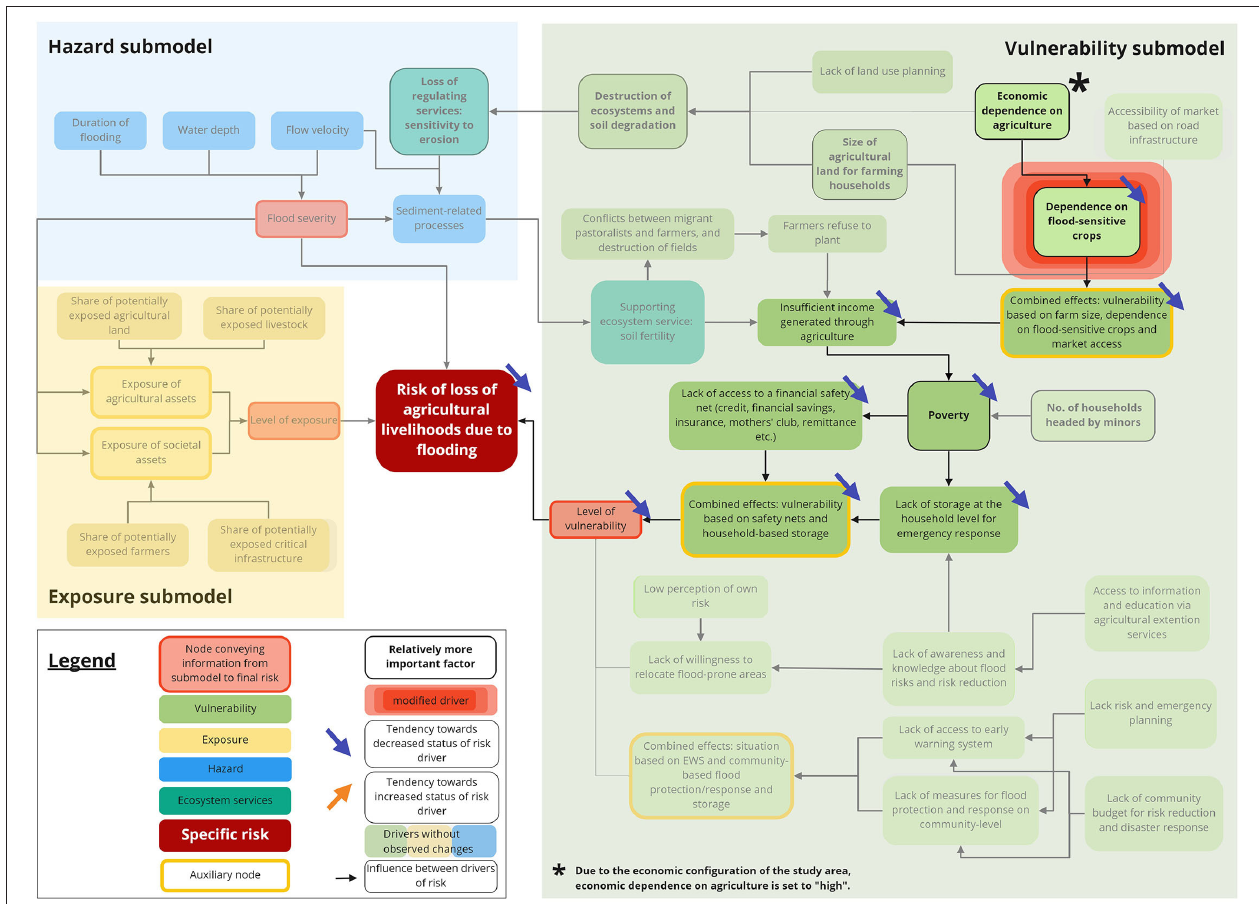
FIGURE 5 | Second illustrative scenario depicting the system behavior if dependence on flood-sensitive crops is observed to be